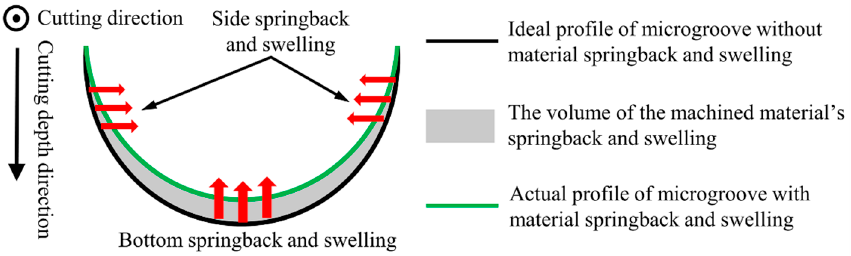
Figure 1. Schematic view of the material swelling and springback in the machining of